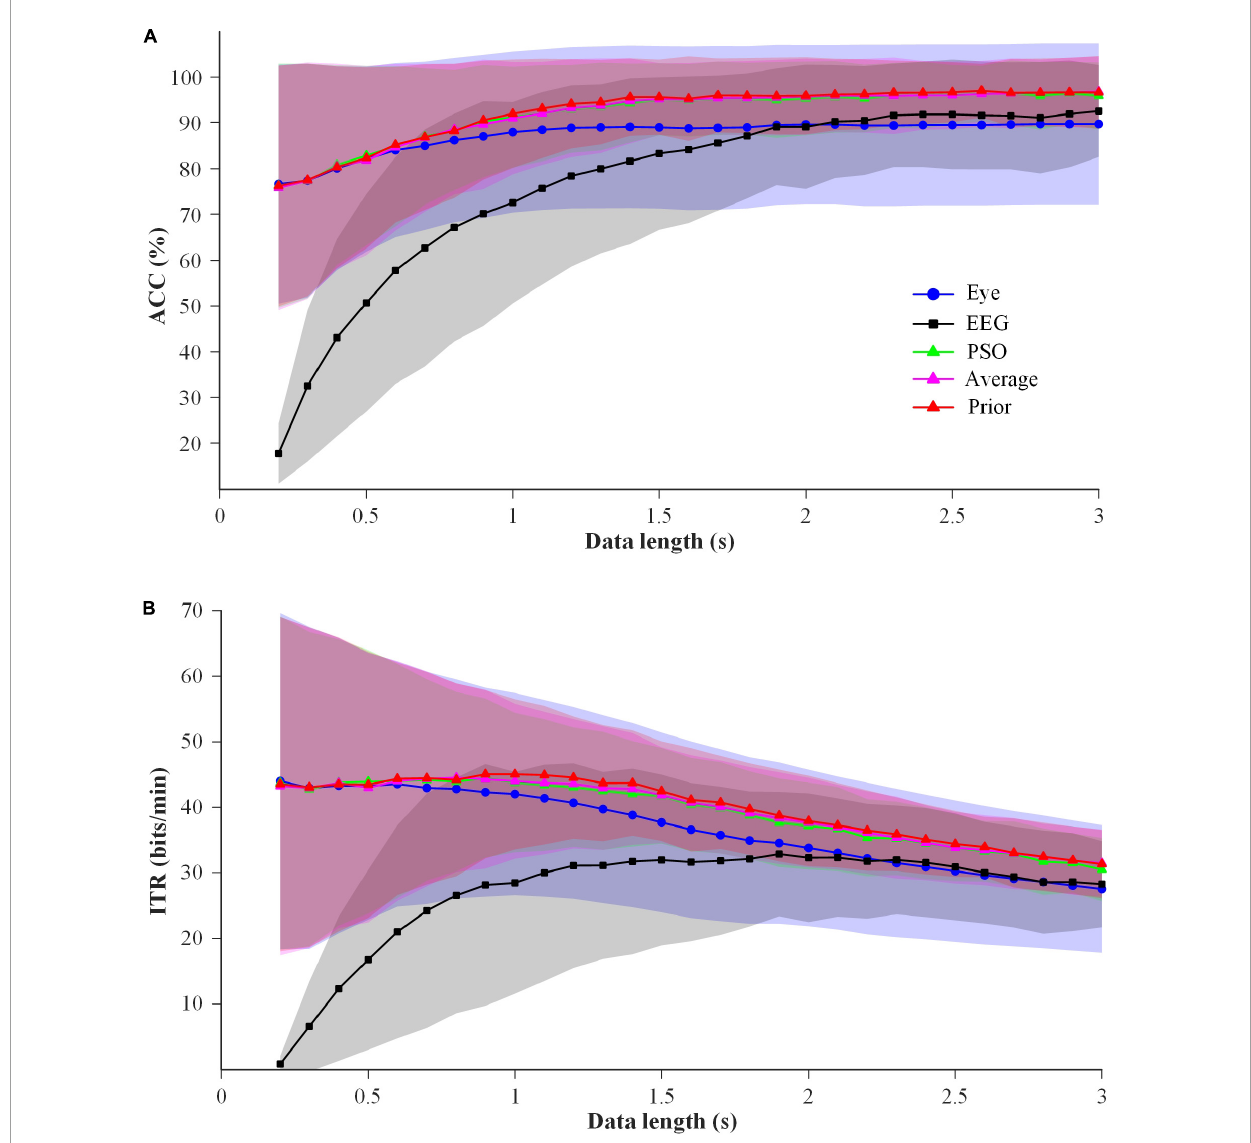
FIGURE7 The performance comparison of the EEG-eye fusion methods with 1 block data for training and 1 block data for testing at data length of 0.2–3 s for all subjects. Shaded area represents standard deviation (A) ACC. (B)